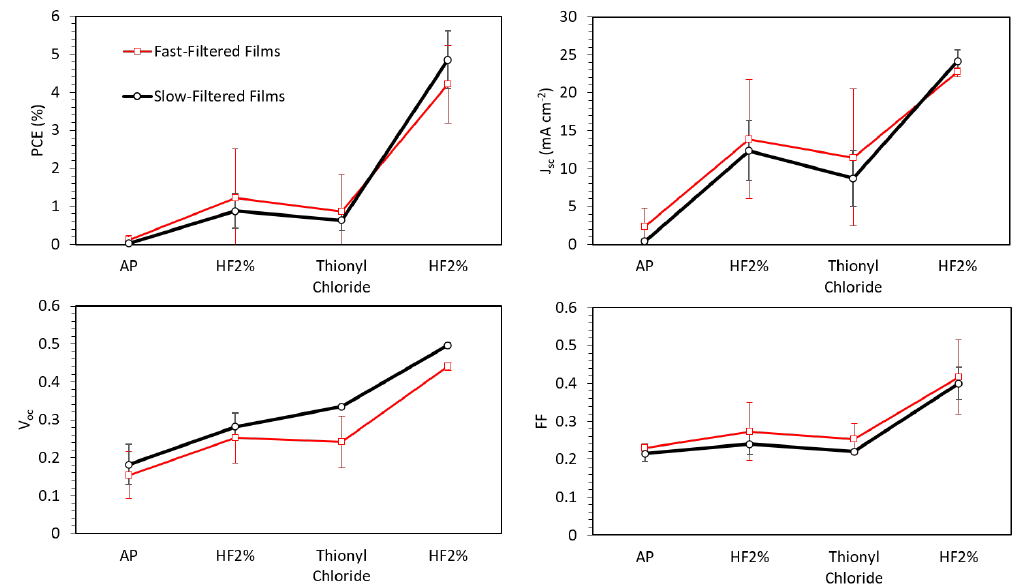
Figure 6. J/V properties for devices with 400 µL aliquot slow and fast-filtered arc-discharge SWCNT films. Where PCE is Percent Current Efficiency, J sc is Short-Circuit Current Density, V oc is Open Circuit Voltage, and FF is the Fill Factor.